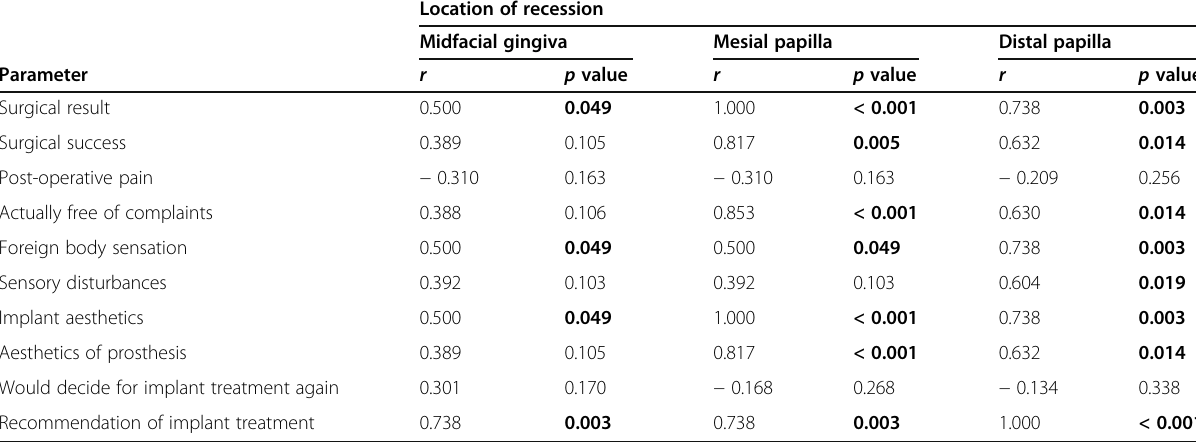
Table 3 Significant correlation between specific PROMs and midfacial recession/loss of papilla height Location of recession Midfacial gingiva Mesial papilla Distal